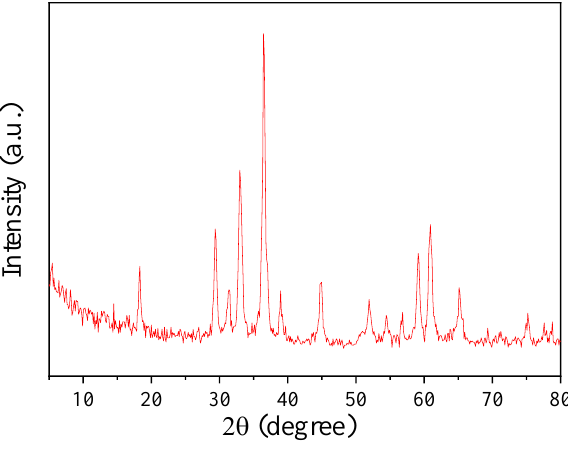
Figure 2. X-ray diffraction (XRD) pattern of CoMn 2 O 4 .